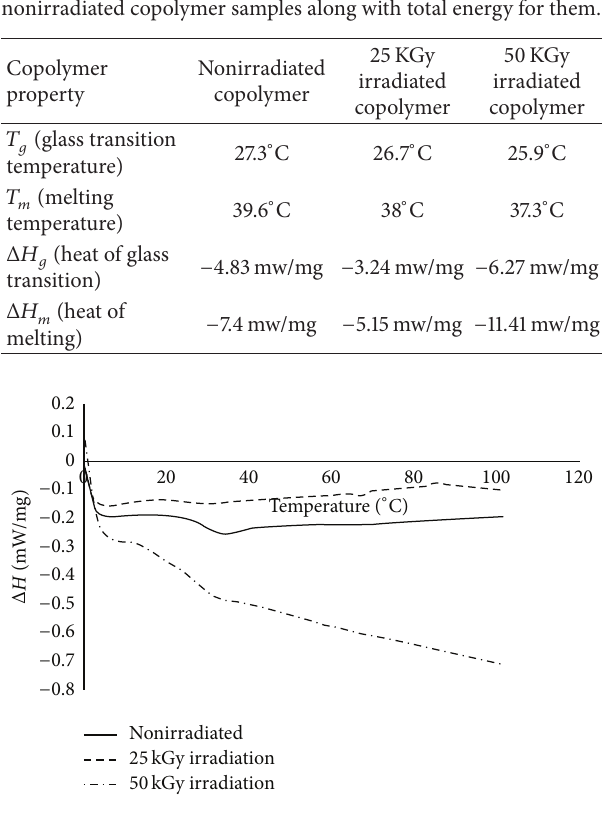
Figure 7: DSC diagram of copolymers irradiated with 0, 25, and 50 KGy doses of gamma irradiation.